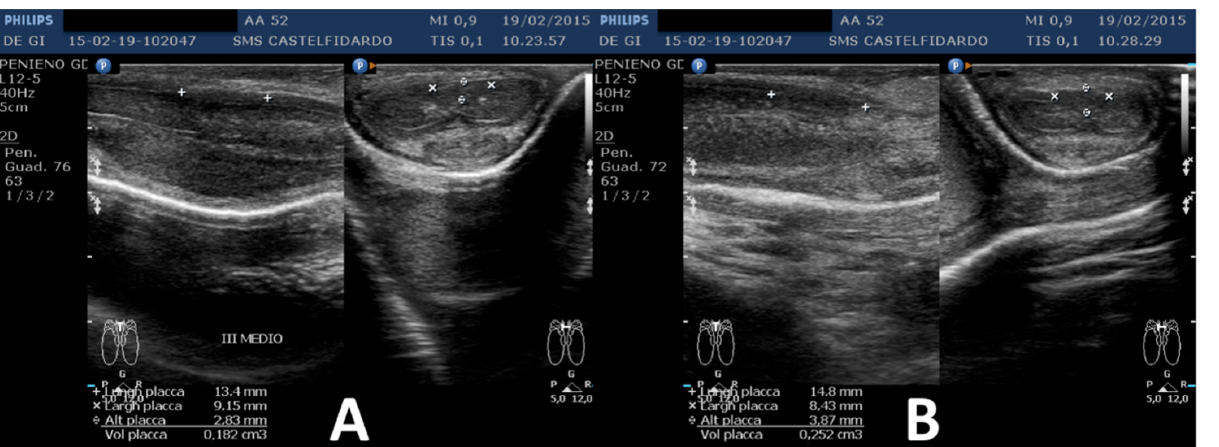
Figure 7. Ultrasonography of the penis after the first treatment cycle (longitudinal and transverse views). ( A ) First plaque. ( B ) Second plaque.